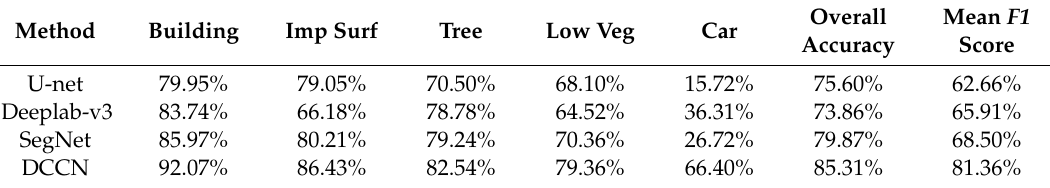
Table 5. Quantitative comparisons of di ff erent methods with the Vaihingen dataset.